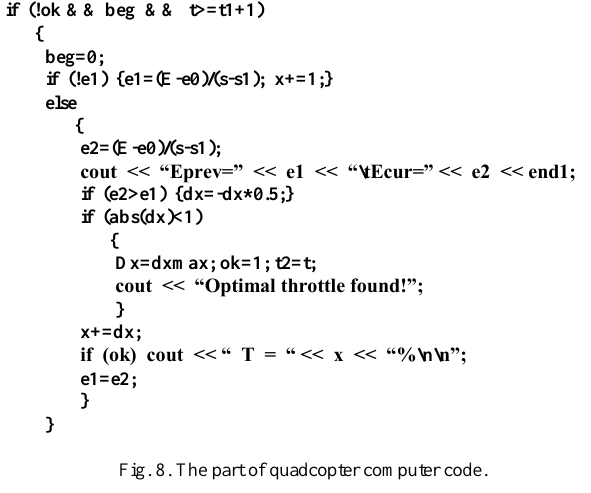
Fig. 8. The part of quadcopter computer code.